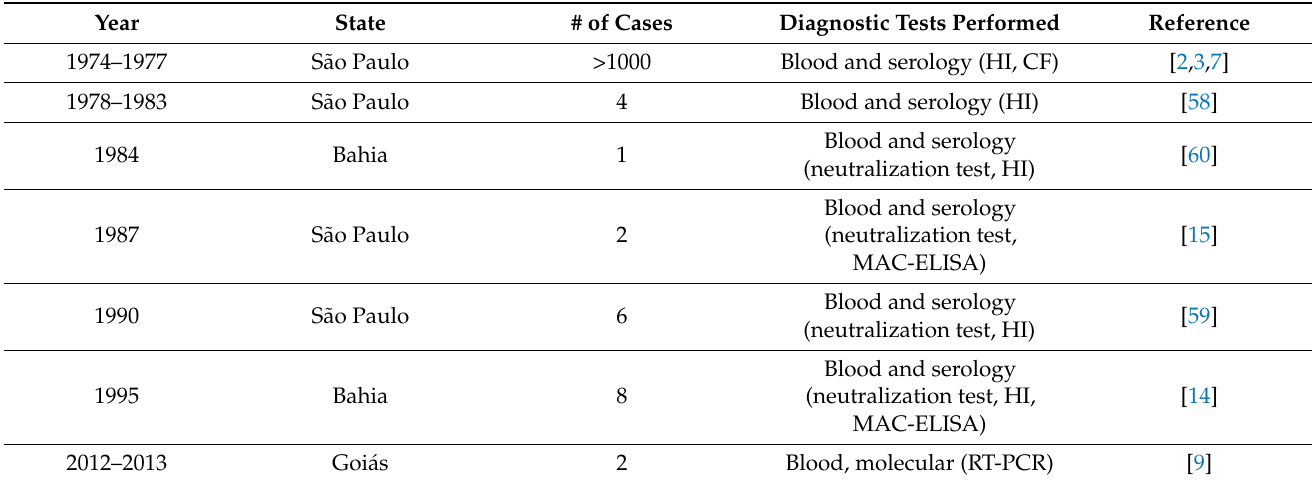
Table 1. Documented circulation of ROCV among